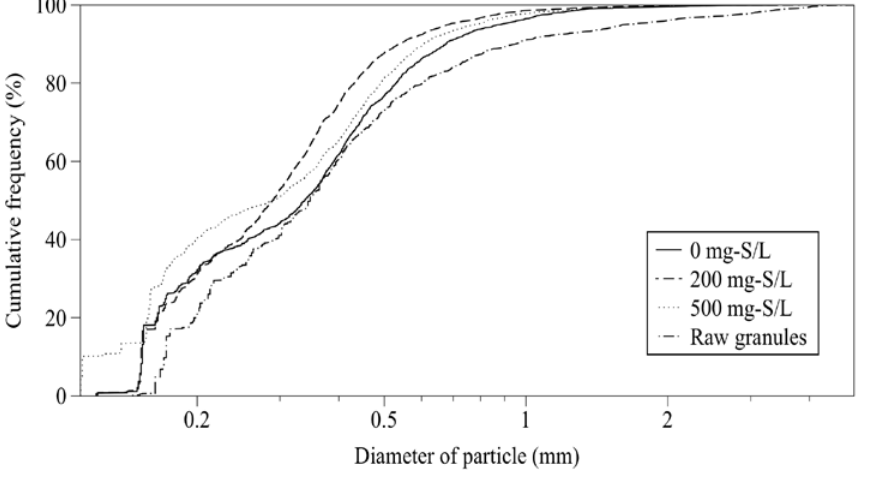
Figure 5. Size distributions of the particles (>0.1 mm) after 8 h of the experiment at different concentrations of